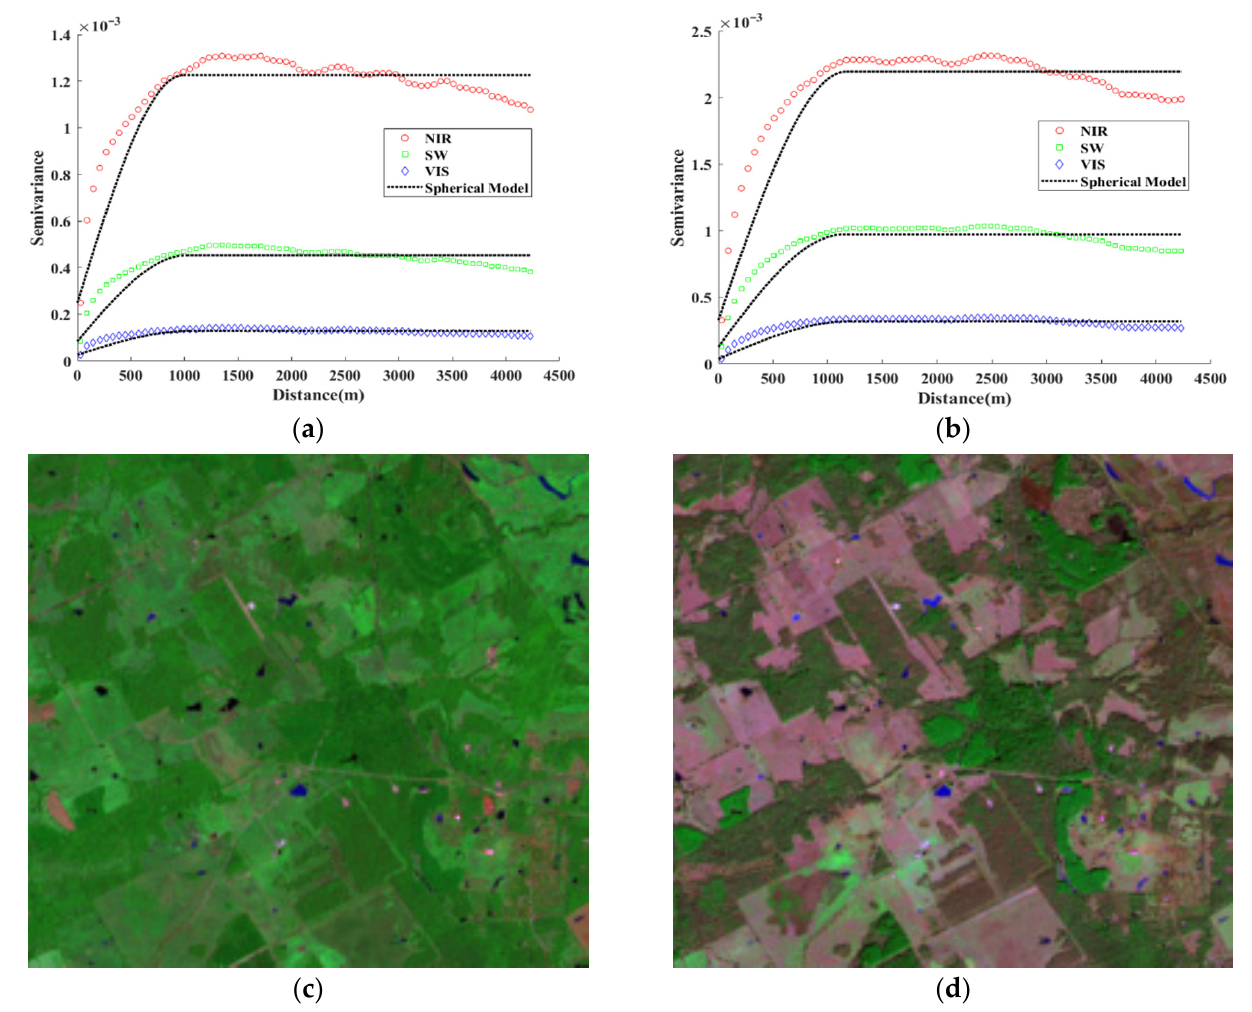
Figure 7. Semi-variogram curves and Landsat-8 OLI images (Savanna, band 7–5–3). ( a ) Semi- variogram (Savanna, DOY 205); ( b ) Semi-variogram (Savanna, DOY 365); ( c ) Landsat-8 bands 7–5–3 (Savannas, DOY 205); ( d ) Landsat-8 bands 7–5–3 (Savanna, DOY